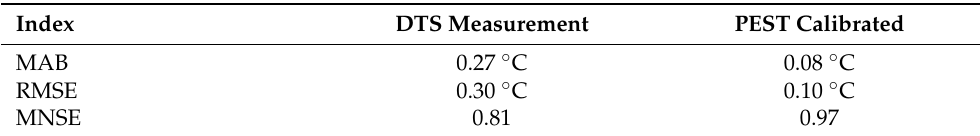
Table 1. Measurement improvement by the PEST